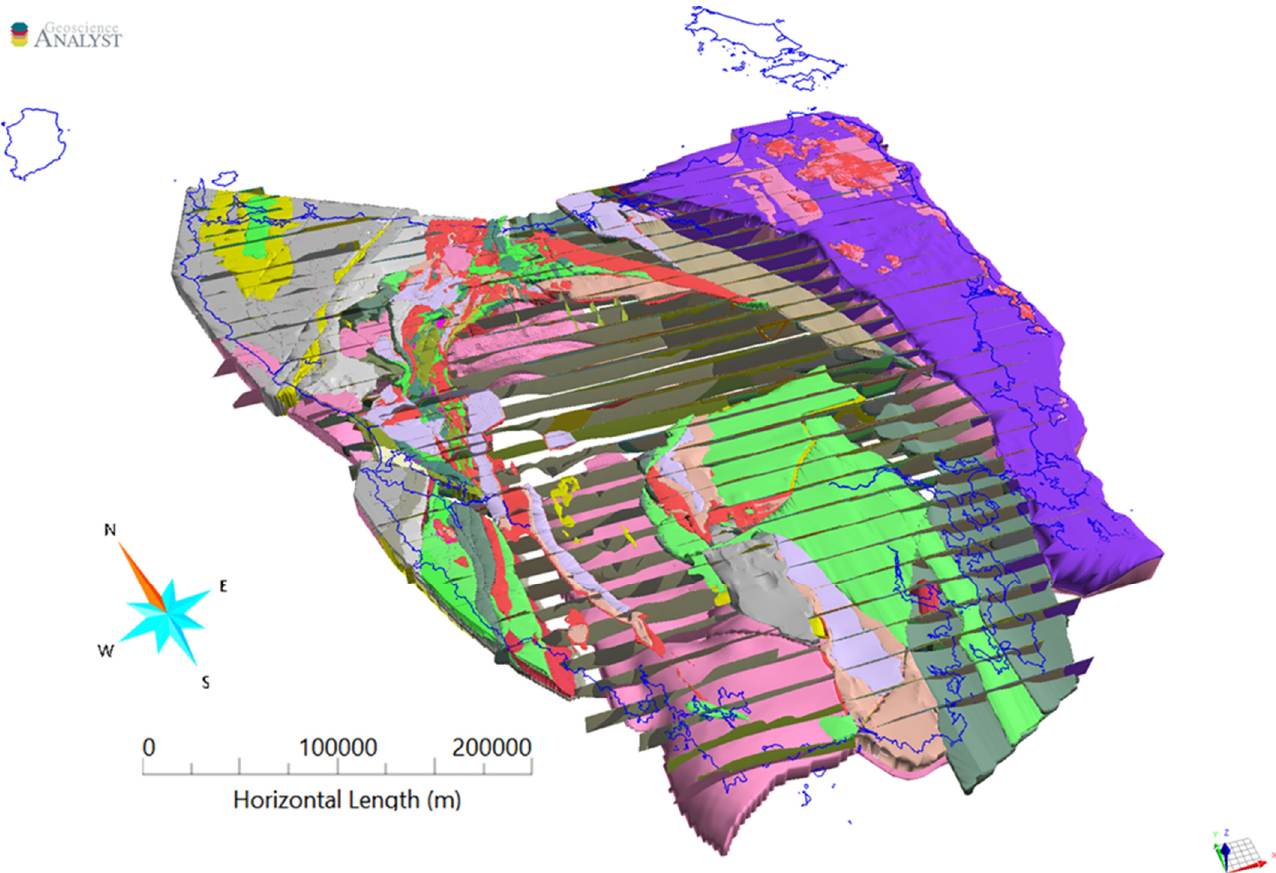
Figure 5. The Statewide 3D geological model of Tasmania including cross-sections. The world’s first 3D model of an entire jurisdiction.